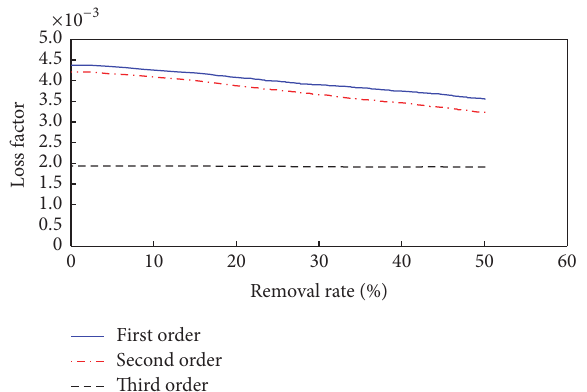
Figure 18: Change of the modal loss factor with the removal rate.